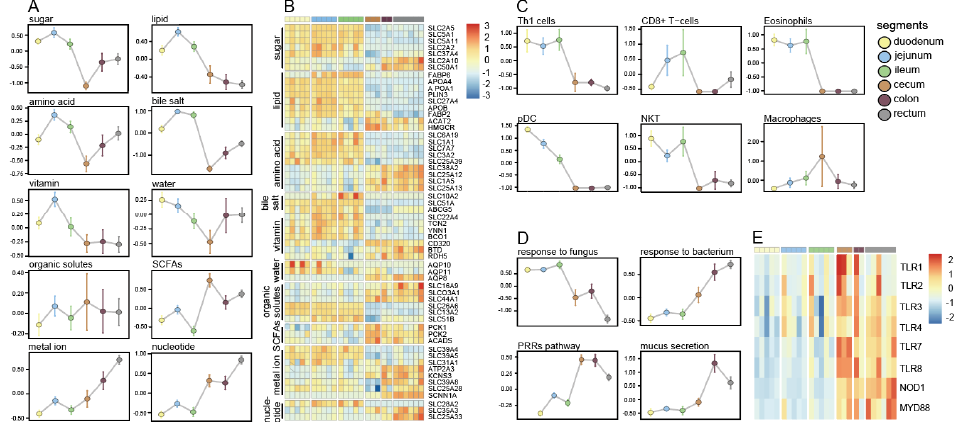
Figure 3. Changes in function among different intestinal segments. ( A ) Expression trends of dige- tion and absorption-related gene sets, the expression levels of genes were normalized; ( B ) Heat map shows the expression levels of genes in different intestinal segments; ( C ) Expression trends of immune-related gene sets; ( D ) Changes in the score of immune cells in the intestine, the results shown in the figure are normalized data; ( E ) The expression levels of immune-related